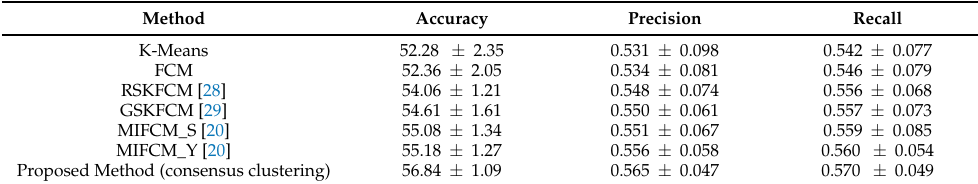
Table 3. Performance comparison for Autism Spectrum Disorder